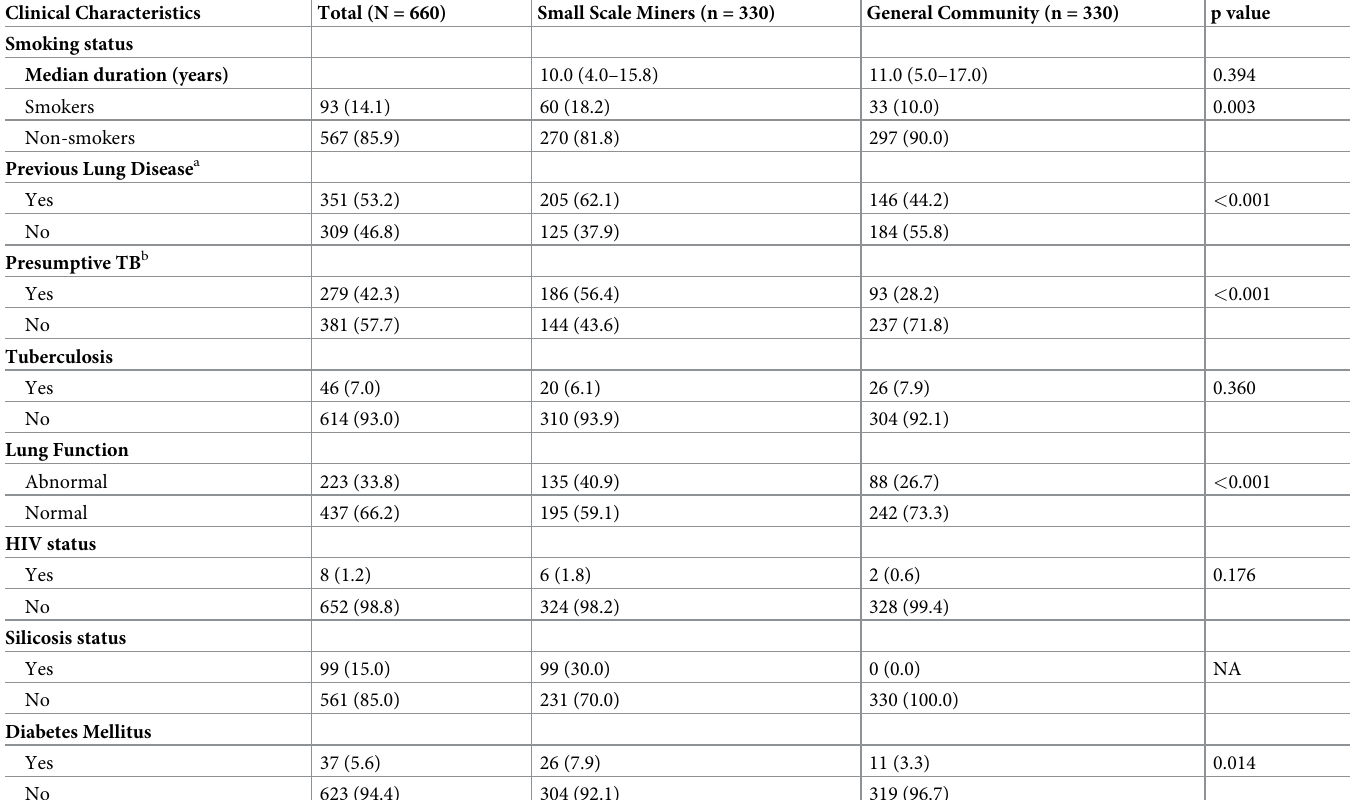
Table 2. Clinical characteristics of the mining communities in Mererani (N =